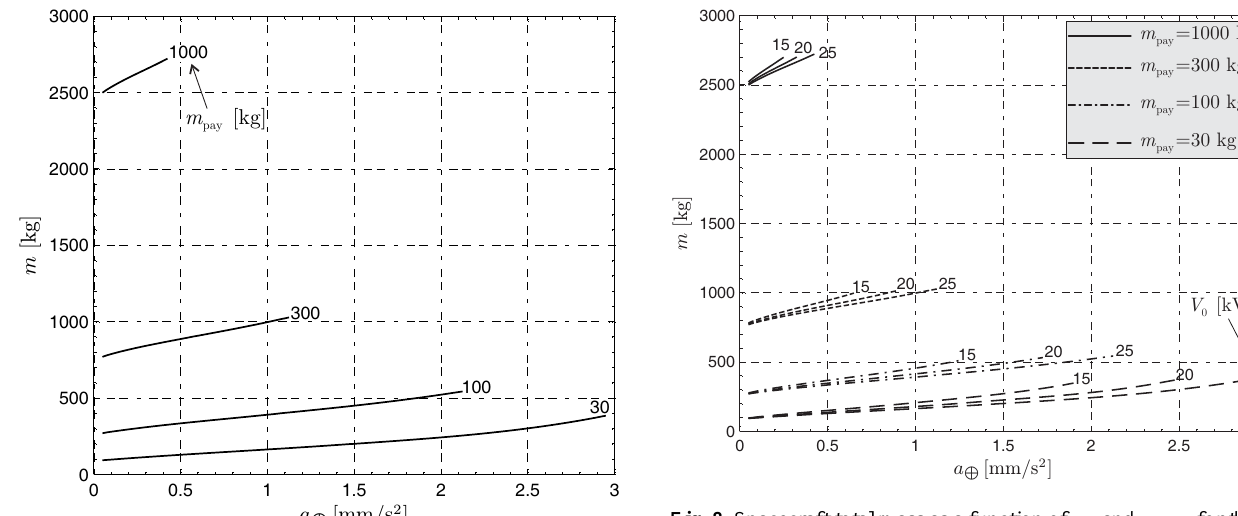
Fig. 8. Spacecraft total mass as a function of a ⊕ and m pay , for three values of V 0 : 15, 20 and 25 kV.